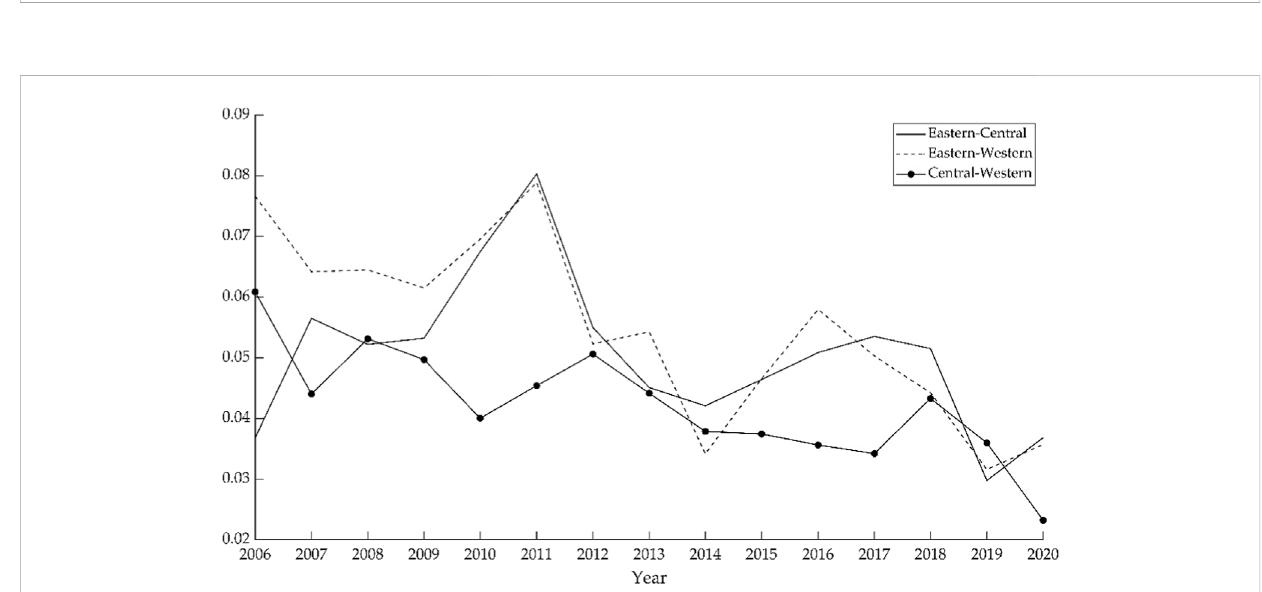
FIGURE 4 Inter-regional difference line chart of the green development quality of the construction